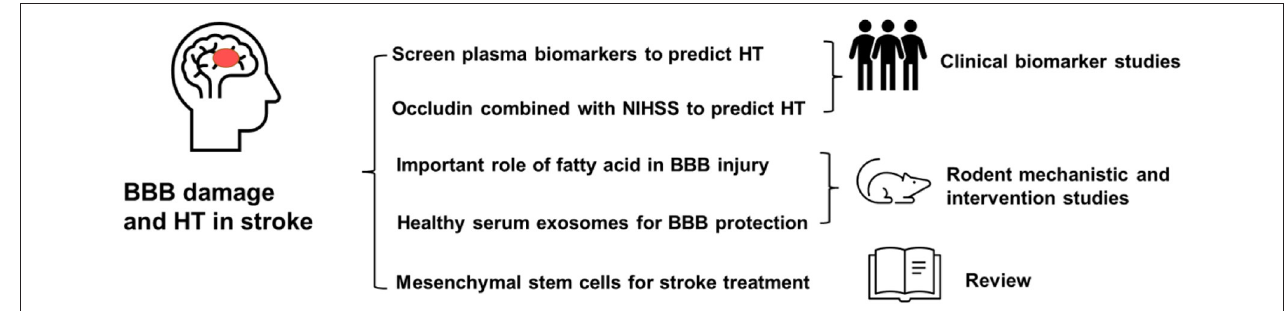
FIGURE 1 | Damage to the blood-brain barrier is important in ischemic brain injury and hemorrhagic transformation. This issue focuses on how to predict HT using plasma biomarkers, recent breakthroughs in BBB damage mechanisms, healthy serum exosome treatment for rodent stroke, and a review of stem cell treatment for